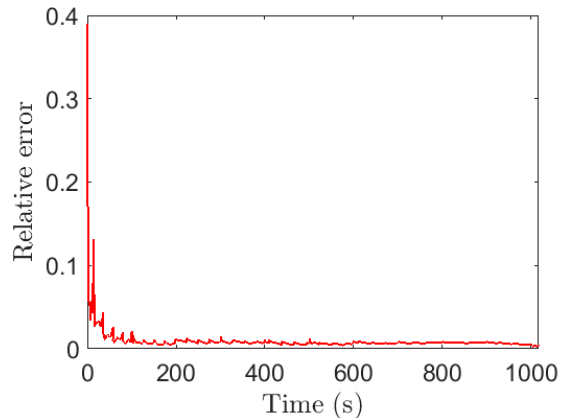
Figure 14. Relative error of proppant concentration with time.